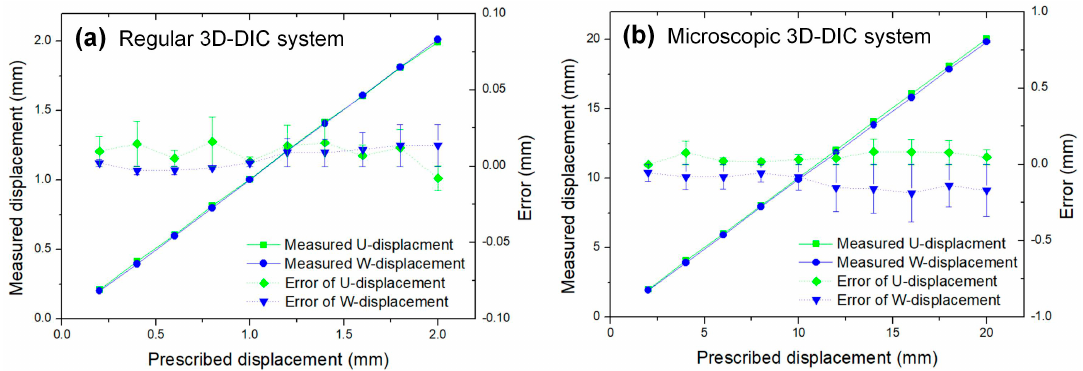
Figure 7. Experimental results of in-plane and out-of-plane translation tests ( a ) regular stereo-DIC measuring system and ( b ) microscopic 3D-DIC measuring system.